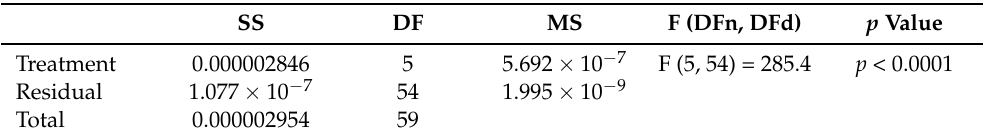
Figure 14. Visualizing the performance of the proposed optimized stacked ensemble in predicting solar radiation. Table 17. ANOVA test applied to the results of the proposed optimized ensemble when applied to the solar radiation